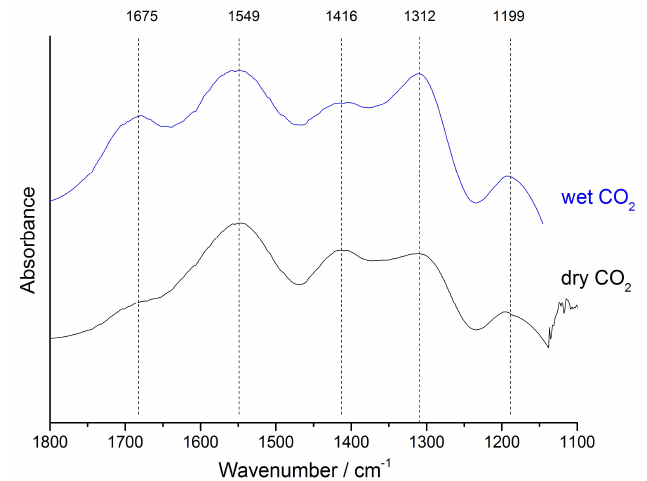
Figure 3. DRIFTS spectra of CO 2 and H 2 O interaction on 0.5 wt. % Au/TiO 2 : CO 2 adsorption saturated with water (wet CO 2 ) and not (dry CO 2 ).